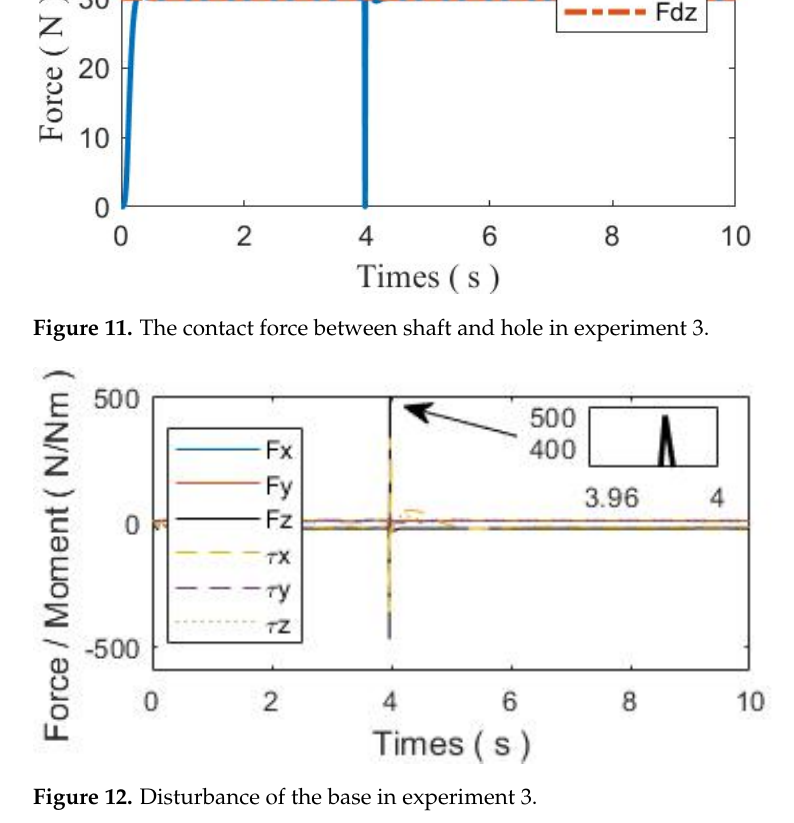
Table 3. The comparison between the experiments.